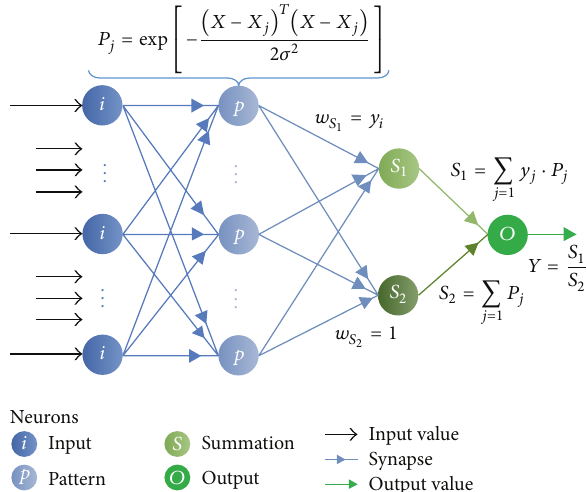
Figure 1: A structure schematic chart of GRNN (where 𝑗 = 1, 2, ...,𝑛 , 𝑋 is the input variable of the network, 𝑋 of the 𝑗 th neuron in the pattern layer, 𝜎 denotes the smoothing parameter(alsocalledspreadparameter), 𝑦 𝑗 isthemeasuredvalueof the output variable, 𝑃 𝑗 is the pattern Gaussian function, 𝑤 𝑆 are the network weights, 𝑆 1 and 𝑆 2 are the signals from summation neurons, and 𝑌 is the network